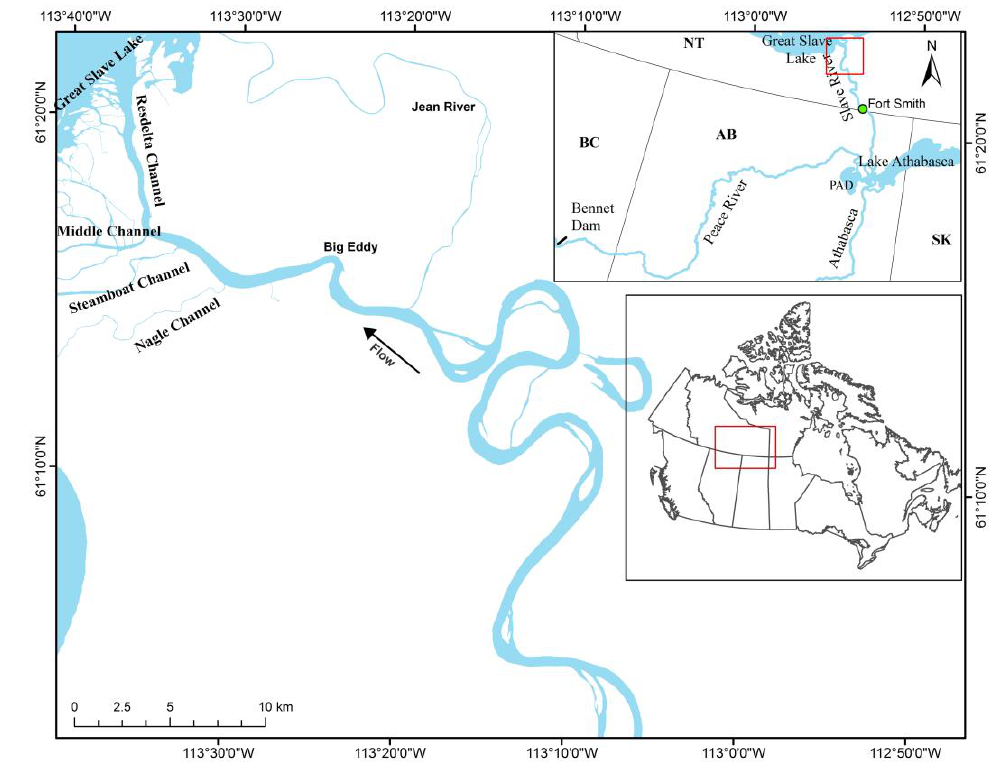
Figure 1. Study area in the Slave River Delta. The study area was zoomed in the red color